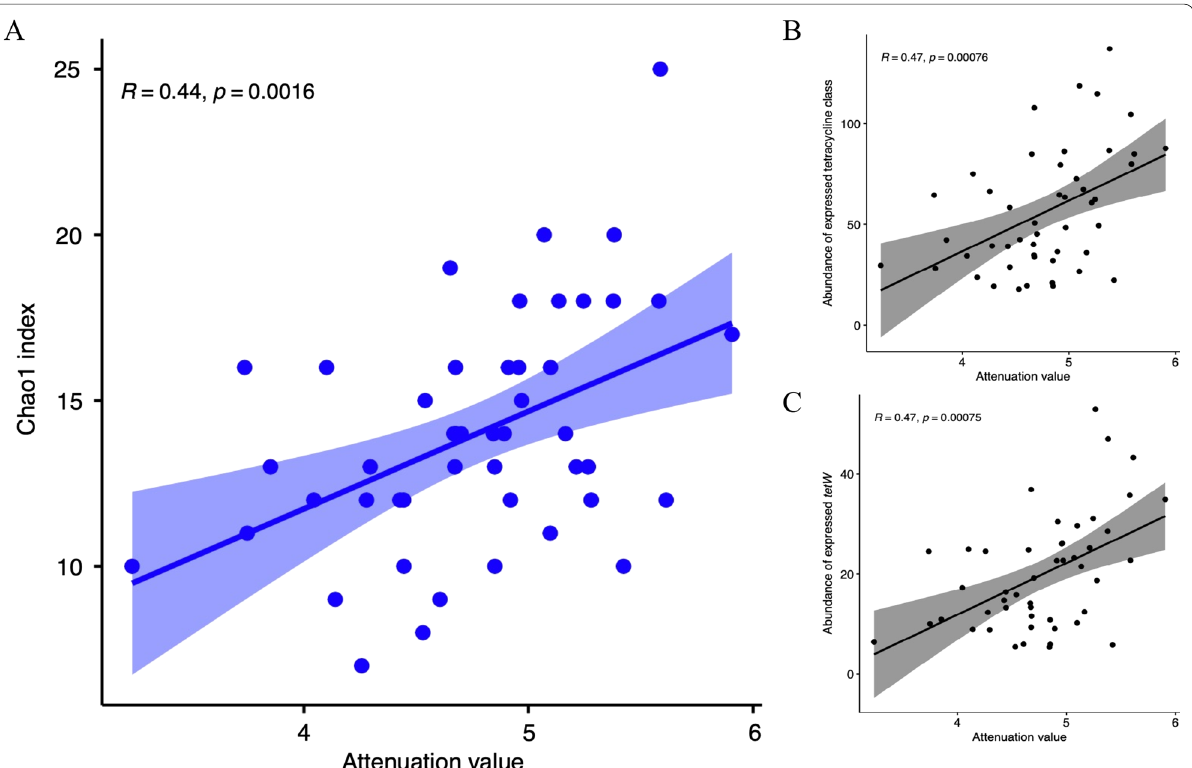
Fig. 7 Functions of active resistome. a Spearman correlation between the Chao1 index of expressed ARGs and attenuation values of active rumen microbiota. b Spearman correlation between the abundance of expressed ARGs in tetracycline class and attenuation values of active rumen microbiota. c Spearman correlation between the abundance of expressed tetW and attenuation values of active rumen microbiota. ARG, antimicrobial resistant